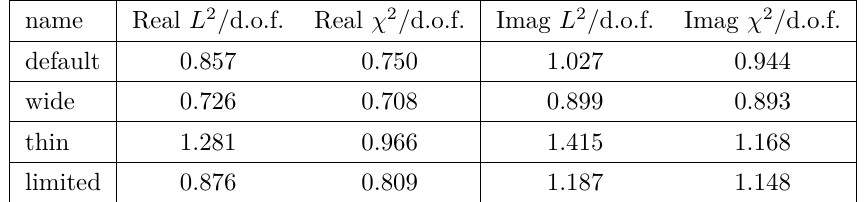
Table 4 . The L 2 and χ 2 of the models used to determine the continuum PDF given in table 3. The model designated as “default” serves as a baseline for this study. This model is the same as the one considered in the previous section where all nuisance terms were